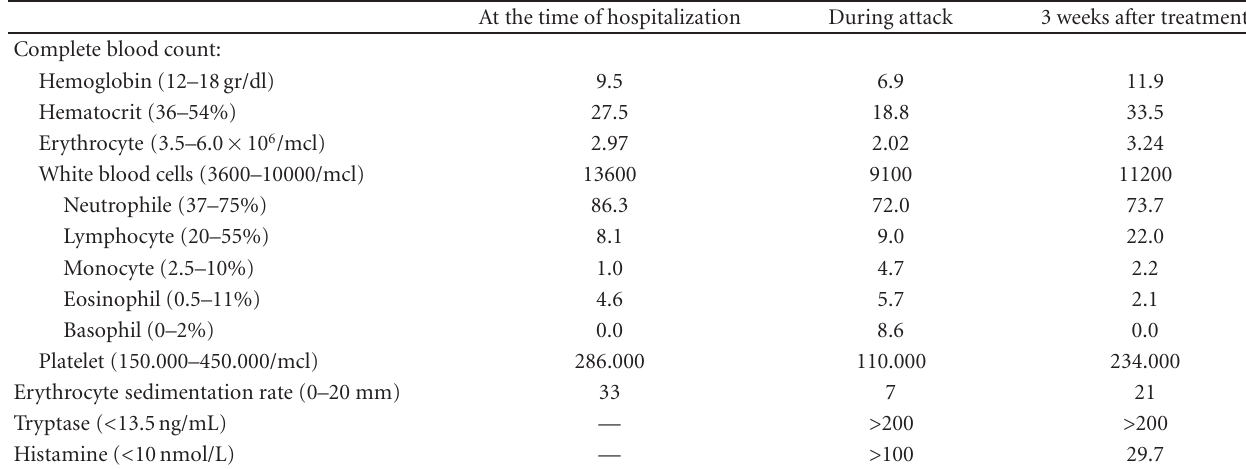
Table 1: Laboratory data at first admission, during attack and after